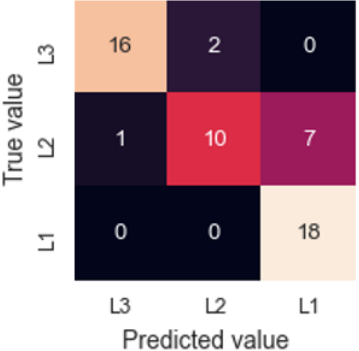
Figure 7. Confusion matrix for cork slab Figure 7. C onfusion matrix for cork slab results. Figure 7. C onfusion matrix for cork slab results.